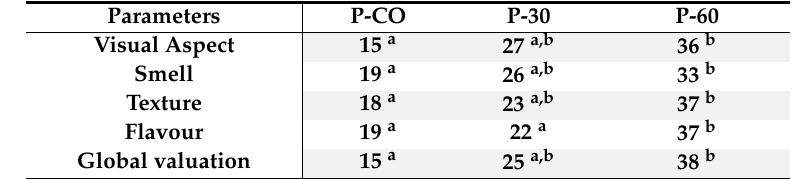
Table 4. Friedman test results using a valuation of 1, 2 or 3 for the preferred sample, second preferred sample and the third preferred sample, respectively. F(test) > F( α = 0.05).